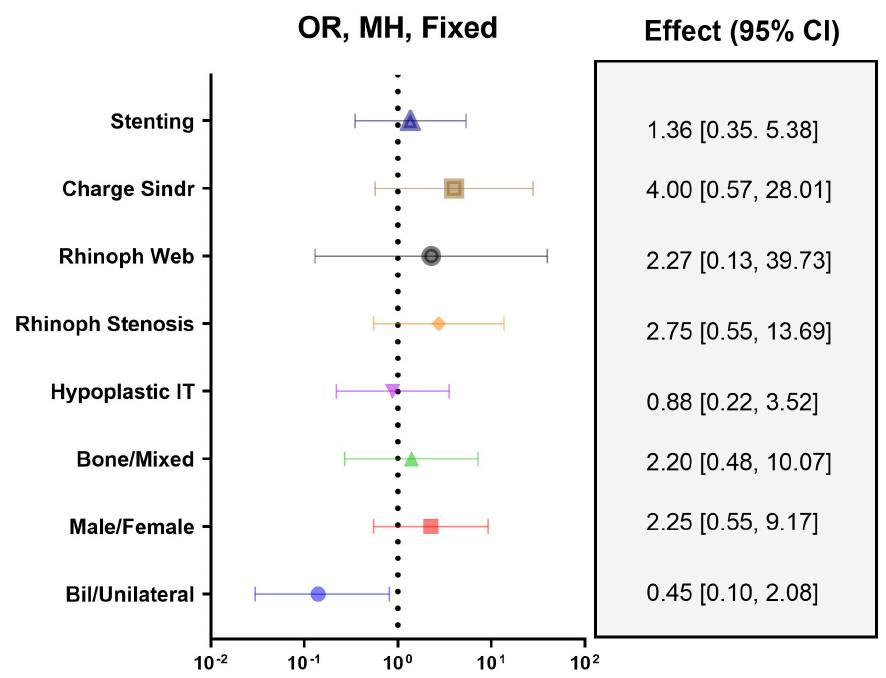
Figure 3. Forest–plot of independent variables for surgical